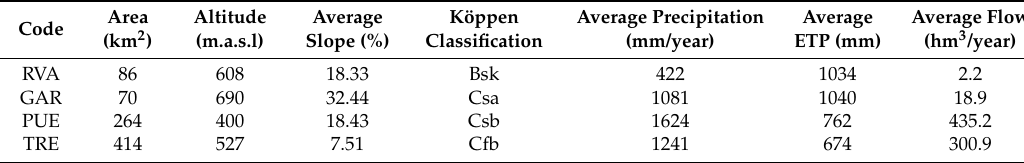
Table 1. Summary of the main characteristics of the selected basins